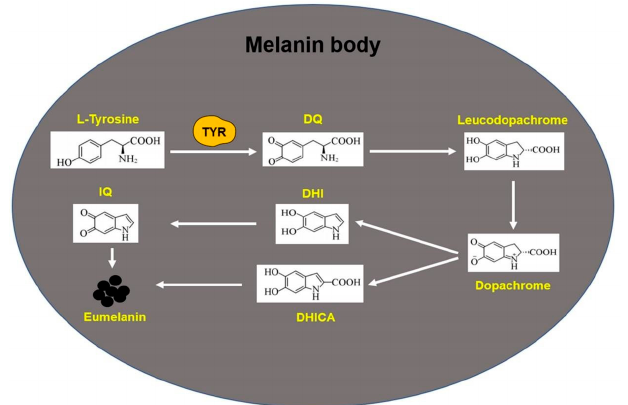
Figure 2. Biosynthesis process of eumelanin. TYR: tyrosinase; DQ: dopaquinone; DHI: 5,6-dihydroxyindole; DHICA: 5,6-dihydroxyindole-2-carboxylic acid; IQ: indole-5,6-quinone. 3. The Targeted Therapeutics of Melanoma Melanoma develops from human pigment cells, mainly occurs in the skin and is the most deadly and aggressive skin cancer [73]. In skin melanoma, based on the extent of cumulative sun damage (CSD), malignant melanomas are classified into high-CSD, low-CSD and low-to-no-CSD melanoma [74]. In the Asian population, melanoma mainly occurs in mucosal and acral sites. The metastasis of melanoma cells to vital organs leads to the death of melanoma patients. The occurrence of melanoma is related to ultra- violet (UV) radiation and the increase in the tumor mutation load (TMB) of melanocytes; people with pale skin, red hair and others are at highest risk of developing melanoma, compared to other pigmentation types [75,76]. The high mutation rate of melanoma is largely attributed to the mutagenic effect of ultraviolet light. According to the whole- genome sequences, the genes with significant mutations in skin melanoma include BRAF, CDKN2A, NRAS and TP53, et al. The genes with significant mutations in acral melanoma include BRAF, NRAS and NF1 et al. [77,78]. The genomic classification into four sub-types based on the pattern of the most prevalent significantly mutated genes is mutant BRAF, mutant RAS, mutant NF1 and triple-WT (wild-type) [78]. In the past 10 years, melanoma treatment has made significant progress, from targeting oncogenic BRAF and MEK to checkpoint blockade immunotherapy [79–86]. Unfortunately, the clin- ical benefit of melanoma treatment associated with current immunotherapeutic and molecularly targeted agents is limited by resistance and tumor recurrence [80,87,88]. 3.1. BRAFV600E Mutation As a proto-oncogene, the RAF gene was originally isolated from the murine sarcoma virus isolate 3611 and avian MH2 retrovirus [89,90]. BRAF, encoding a ser- ine/threonine protein kinase, is a key regulatory protein in the RAS/RAF/MEK/ERK